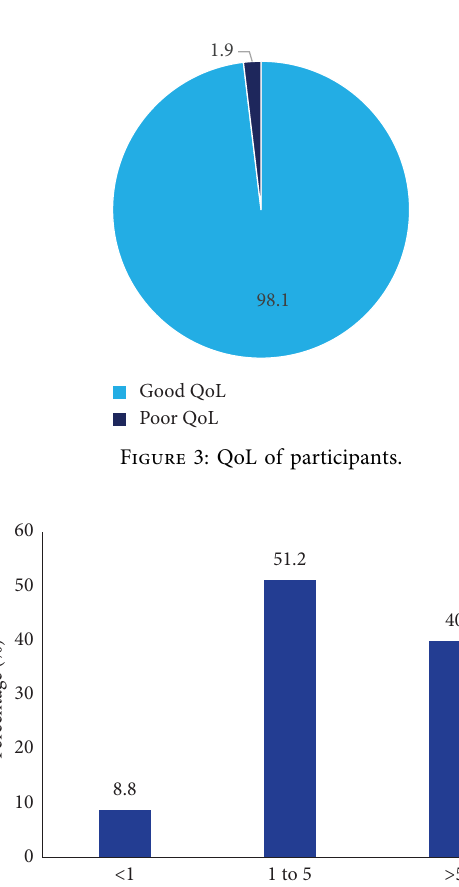
Figure 4: QoL stratifed by years since diagnosis ( p � 0 . 070). Table 3: Internal consistency and summaries of the WHO quality of life